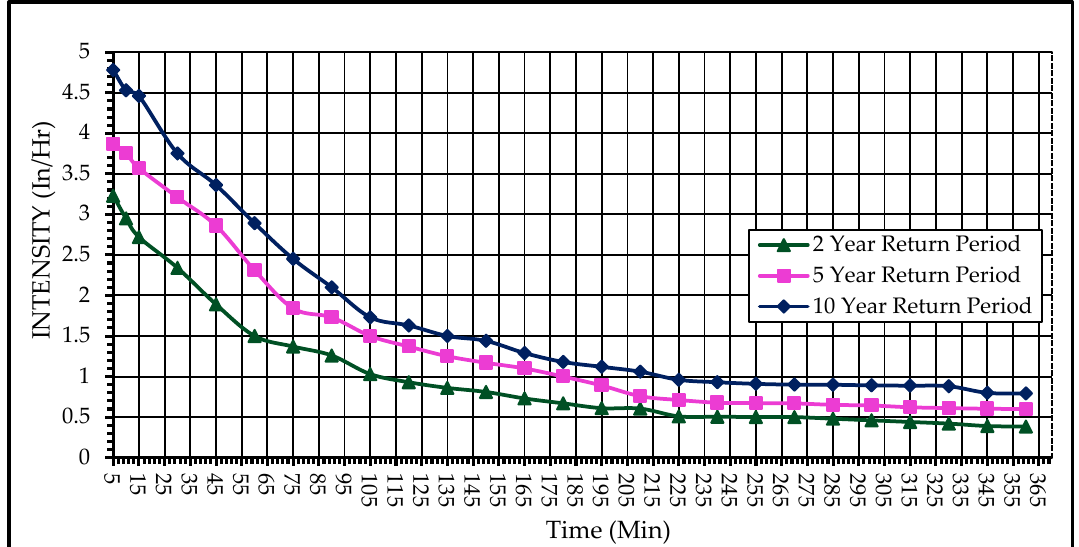
Figure 10. Intensity duration frequency (IDF) for Lahore city.